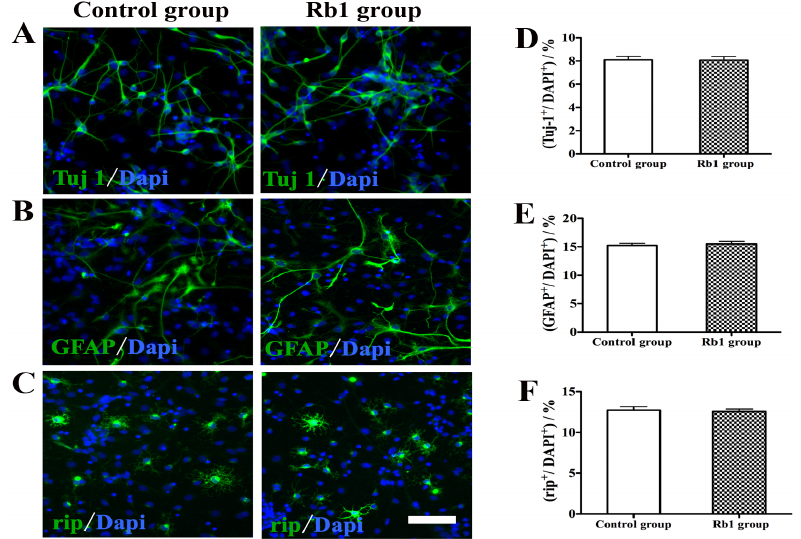
Figure 5. Effect of Rb1 on NPCs differentiation. ( A – C ) Representative photomicrographs of Tuj1 staining ( A ); GFAP staining ( B ); and Rip staining ( C ); ( D – F ) Rb1 pretreatment did not promote neuronal differentiation and alter glial generation by NPCs in culture and the percentages of Tuj-positive cells ( D ); GFAP-positive cells ( E ); and Rip-positive cells ( F ) did not differ between the Rb1 group and control group. Eight representative fields per well and three wells per experiment were counted. Data were presented as means±SEM from six experiments. Scale bar: 75